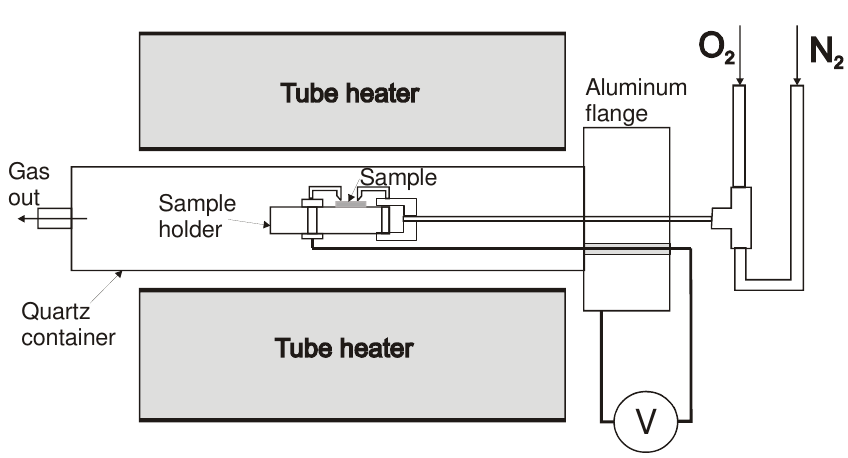
Fig. 1 Experimental setup for measuring the resistance of YSZ thin films at different oxygen contents (air with 21 % oxygen or pure